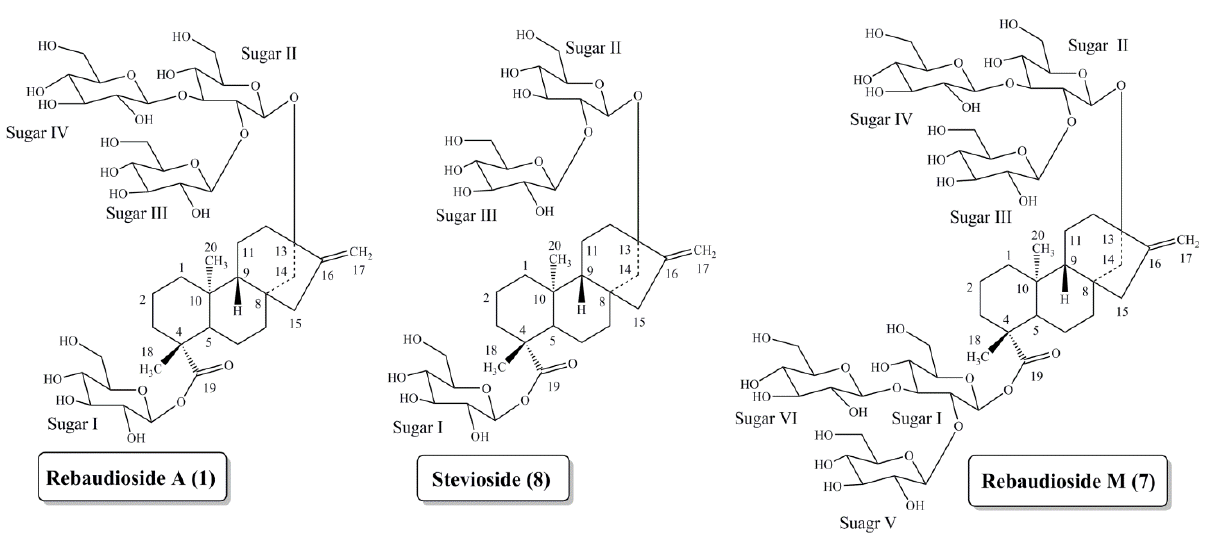
Figure 2. Comparison of the chemical structures of rebaudioside A ( 1 ), stevioside ( 8 ) and rebaudioside M ( 7